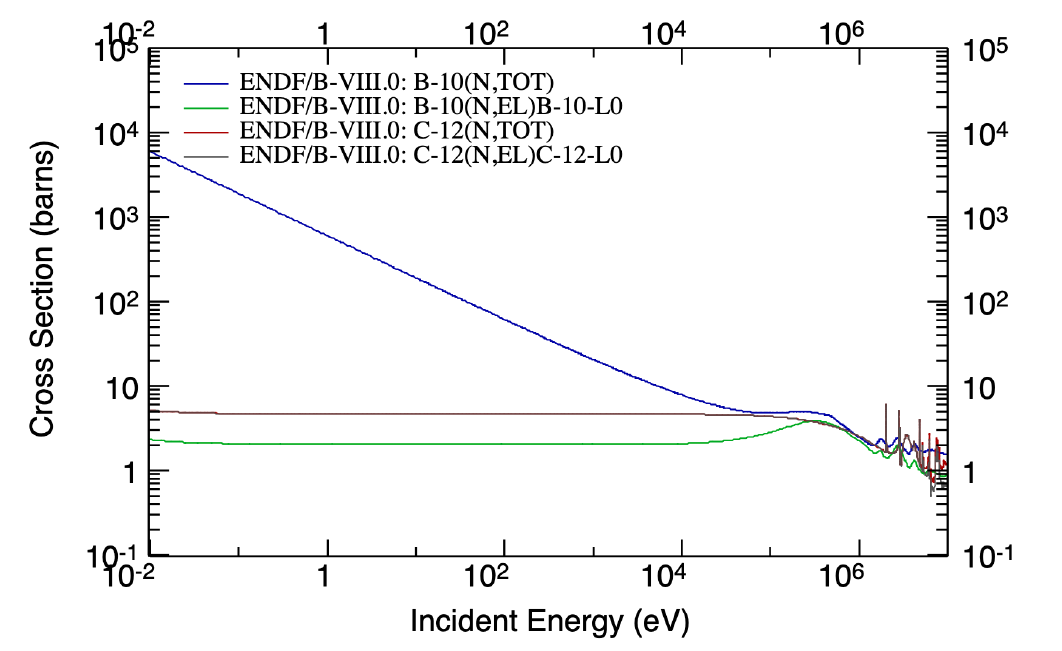
Figure 7. Neutron-induced total and elastic cross sections of 10 B and 12 C. The absorption cross section of 10 B and 12 C is, respectively, orders of magnitudes higher and lower than the elastic cross section. Consequently, 10 B is very effective to absorb low energy neutrons, while 12 C can moderate them, thus reducing the initial kinetic energy. It is worth noticing that the elastic cross section on 12 C almost coincides with the n + 12 C total cross